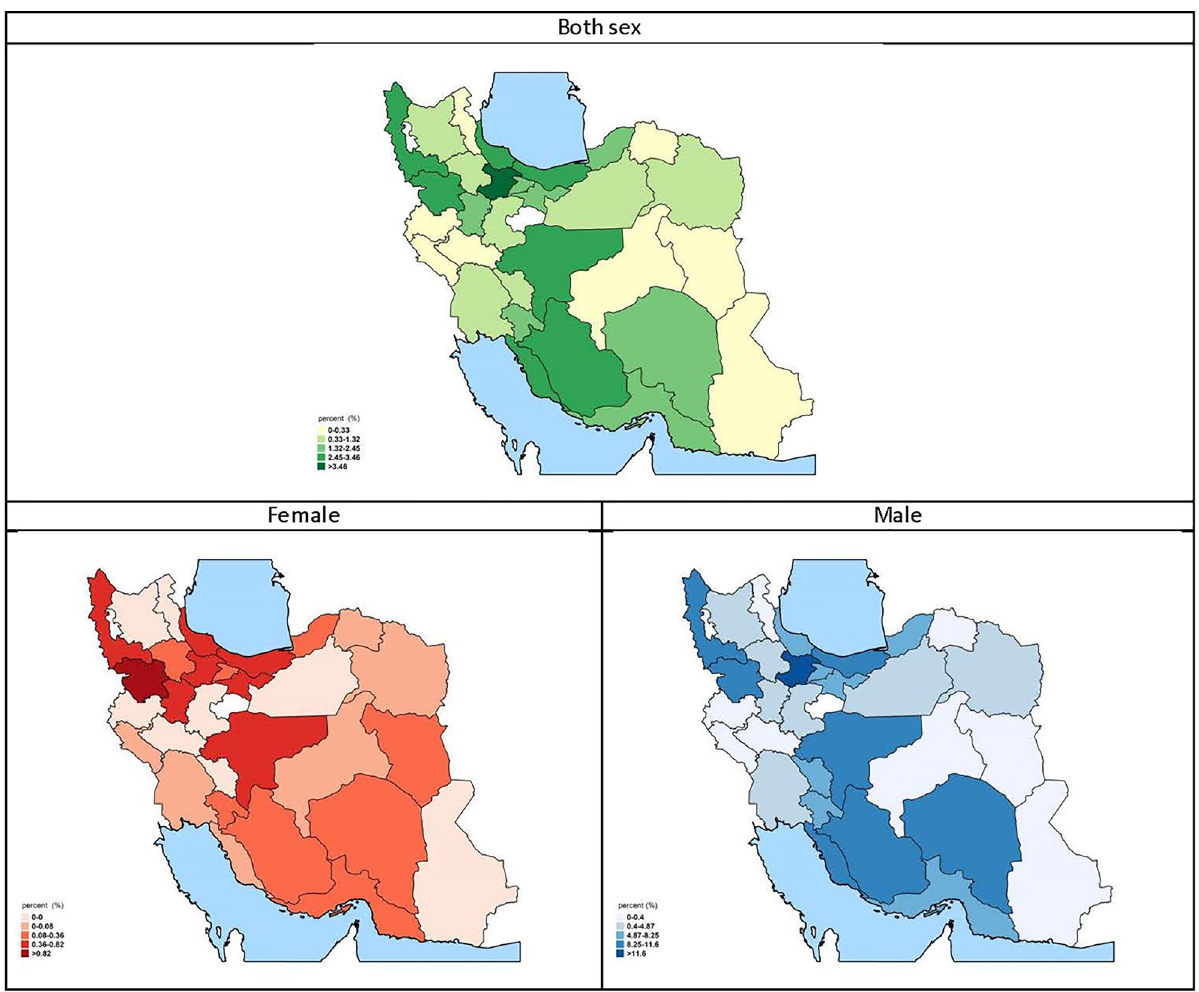
Fig 4. Current alcohol drinking prevalence map of Iran, 2016,